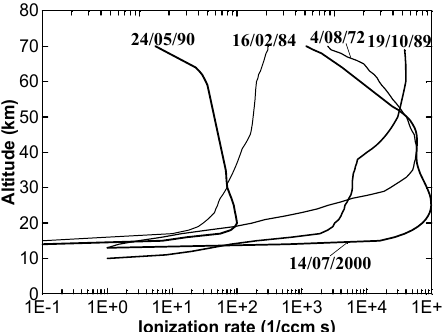
Fig. 1. Ionization rate profiles calculated for GLE events at the time of their maximum.